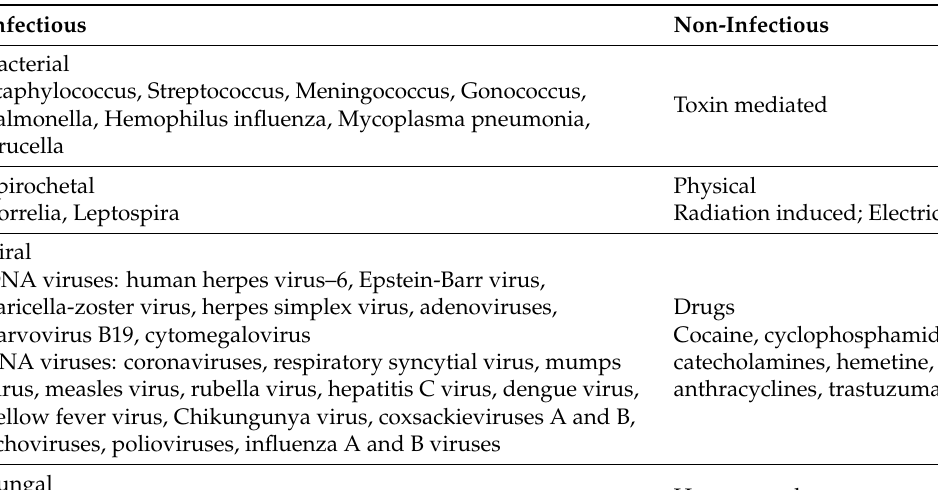
Table 1. Etiology of fulminant